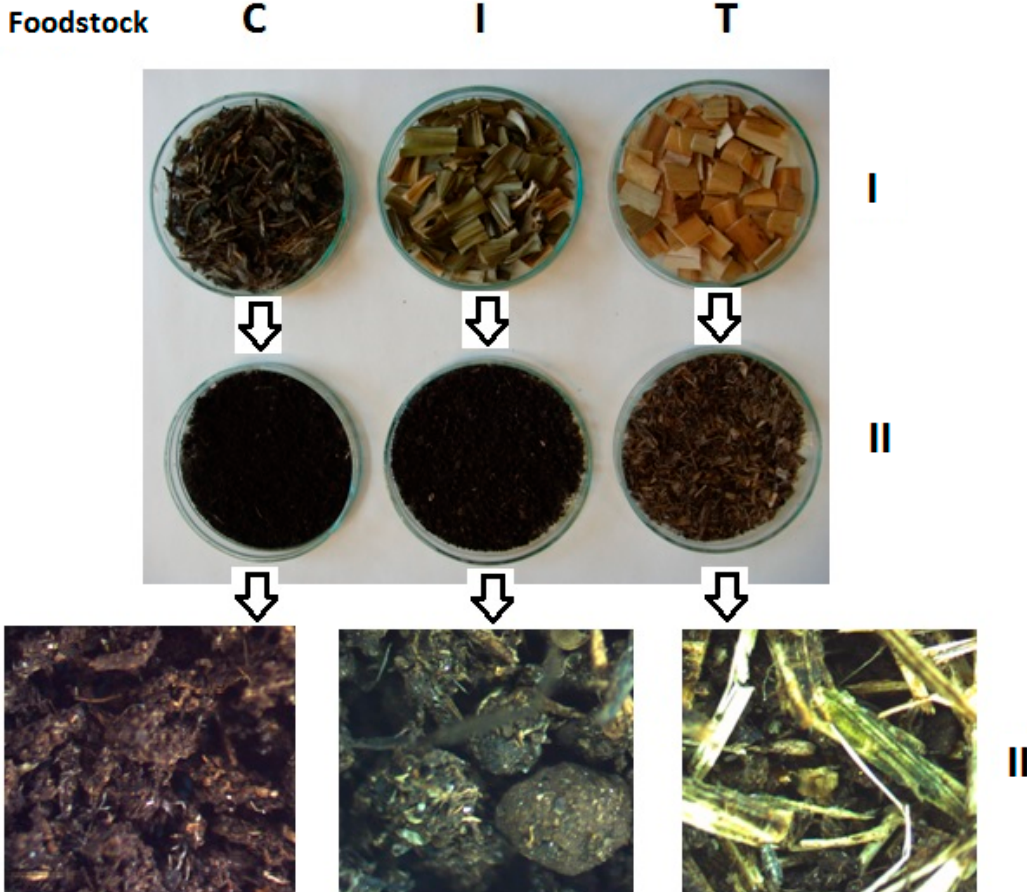
Figure 2. Plant waste processed in vermireactors ( I ), the obtained vermicomposts ( II ), vermicomposts under magnification of x7 ( III ). Species code: C. demersum ( C ), I. pseudacorus ( I ), T. latifolia ( T ).